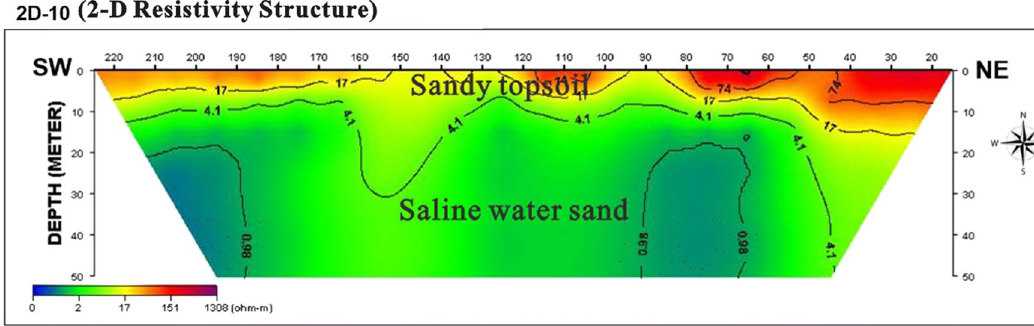
Fig. 14 Resistivity imaging of Traverse 2D-10